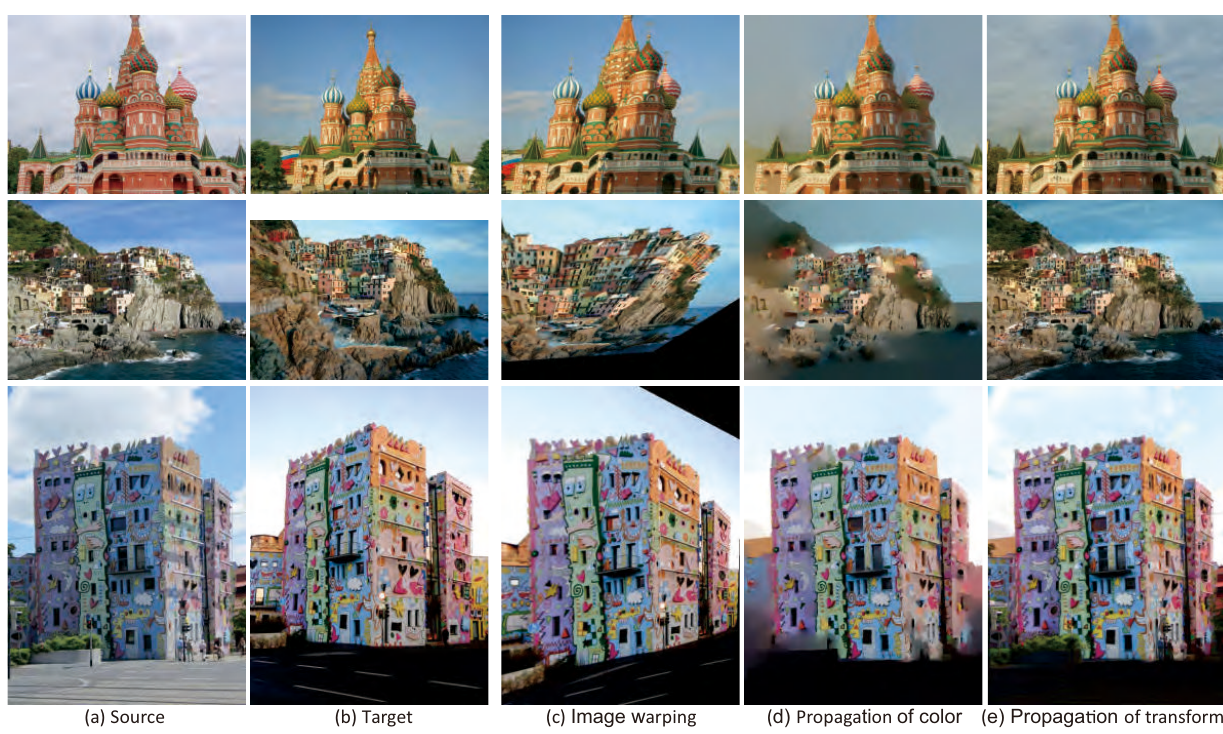
Fig. 5 We compare our method to image warping by homography and naive propagation of color. While the image warping method based on homography (c) distorts the image, and direct propagation of pixel colors (d) blurs image details, our method (e) successfully relights the source images.